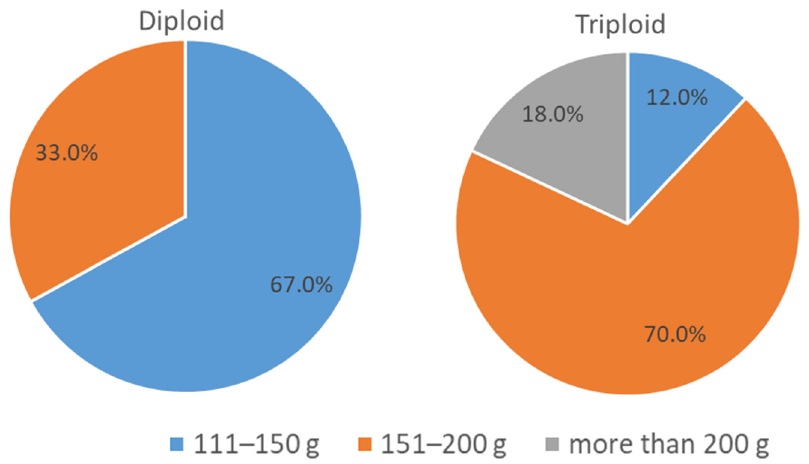
Figure 3. Division of diploid and triploid cultivars by average fruit weight (%). Consumers primarily evaluate apples by their appearance, absence of damage by diseases and pests, one-dimensionality, size. shape, color, and taste, and consumers prefer their familiar and favorite cultivars.